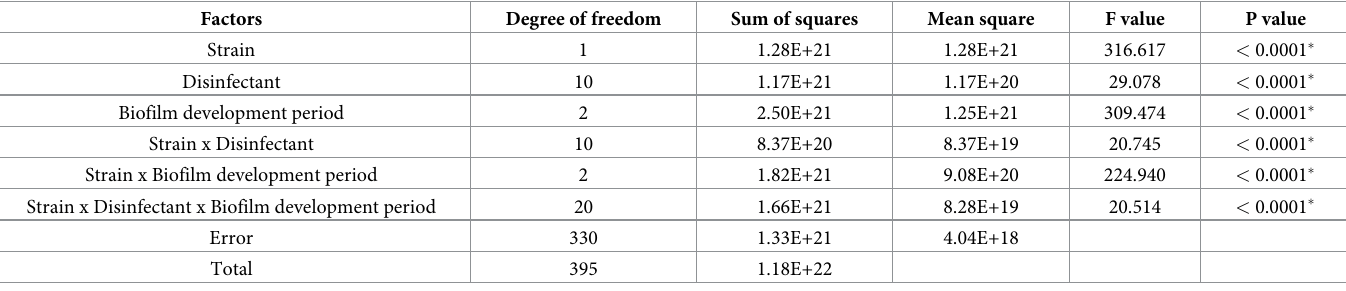
Table 2. Results of 3-way repeated-measures